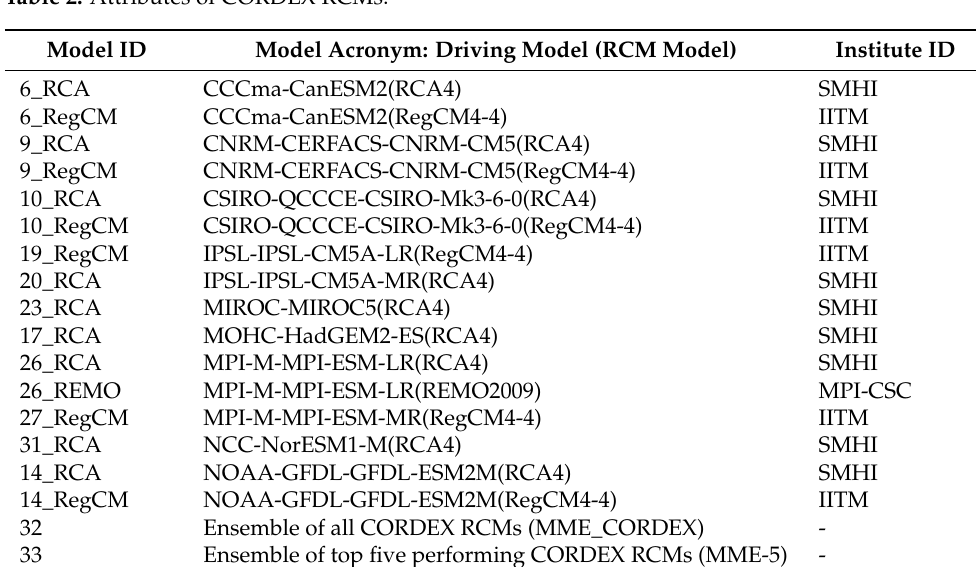
Table 2. Attributes of CORDEX